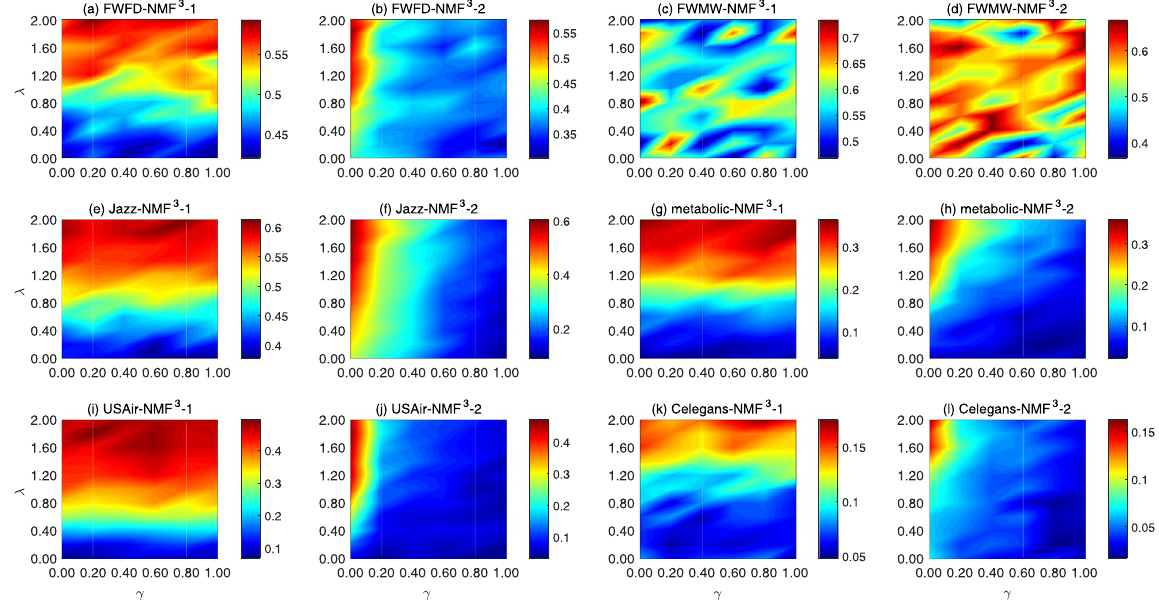
Figure 1. Parameter sensitivity: we conducted the experiments of parameter sensitivity on six networks. We vary the number of γ and the λ to determine their impact on the network link prediction. The Each data point is averaged over 100 independent runs.